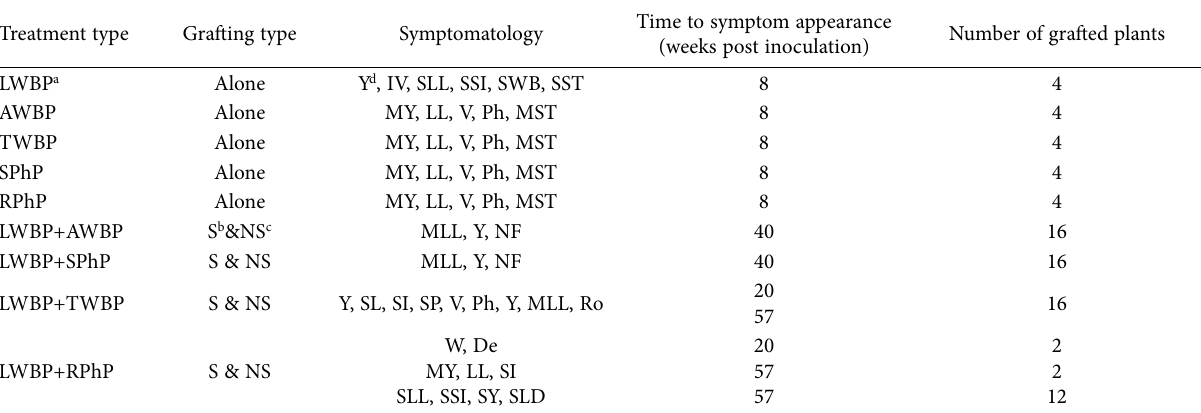
Table 2. Summary of results obtained in the grafted periwinkle plants. Treatment